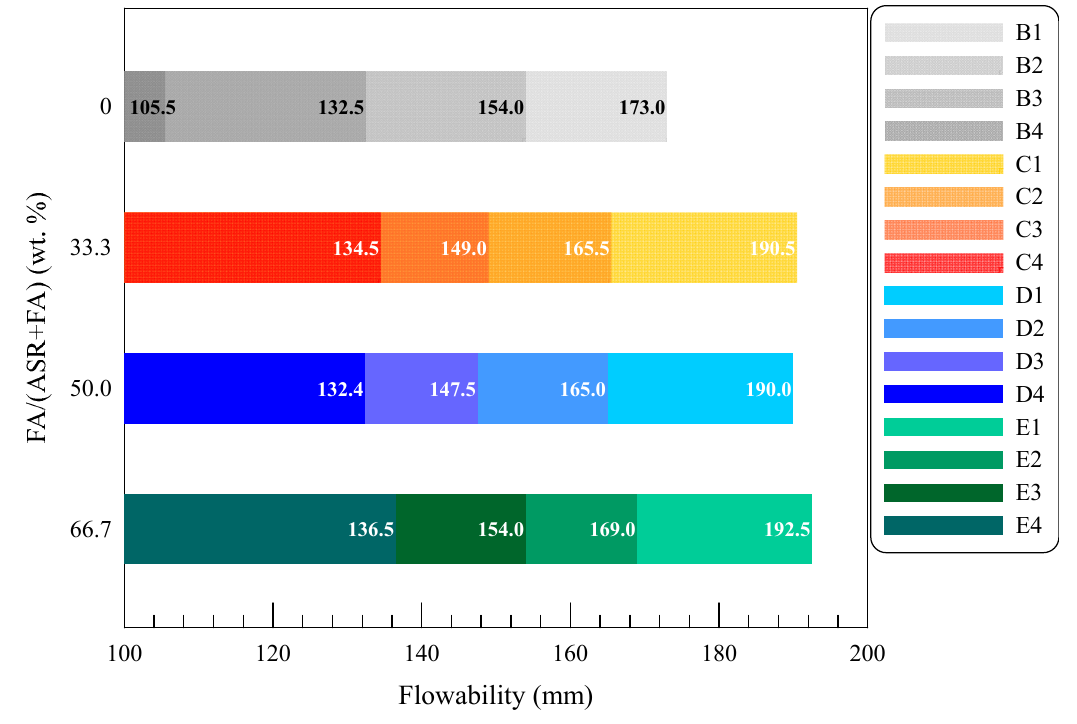
Figure 9. Flowability of MOC pastes with solid wastes.